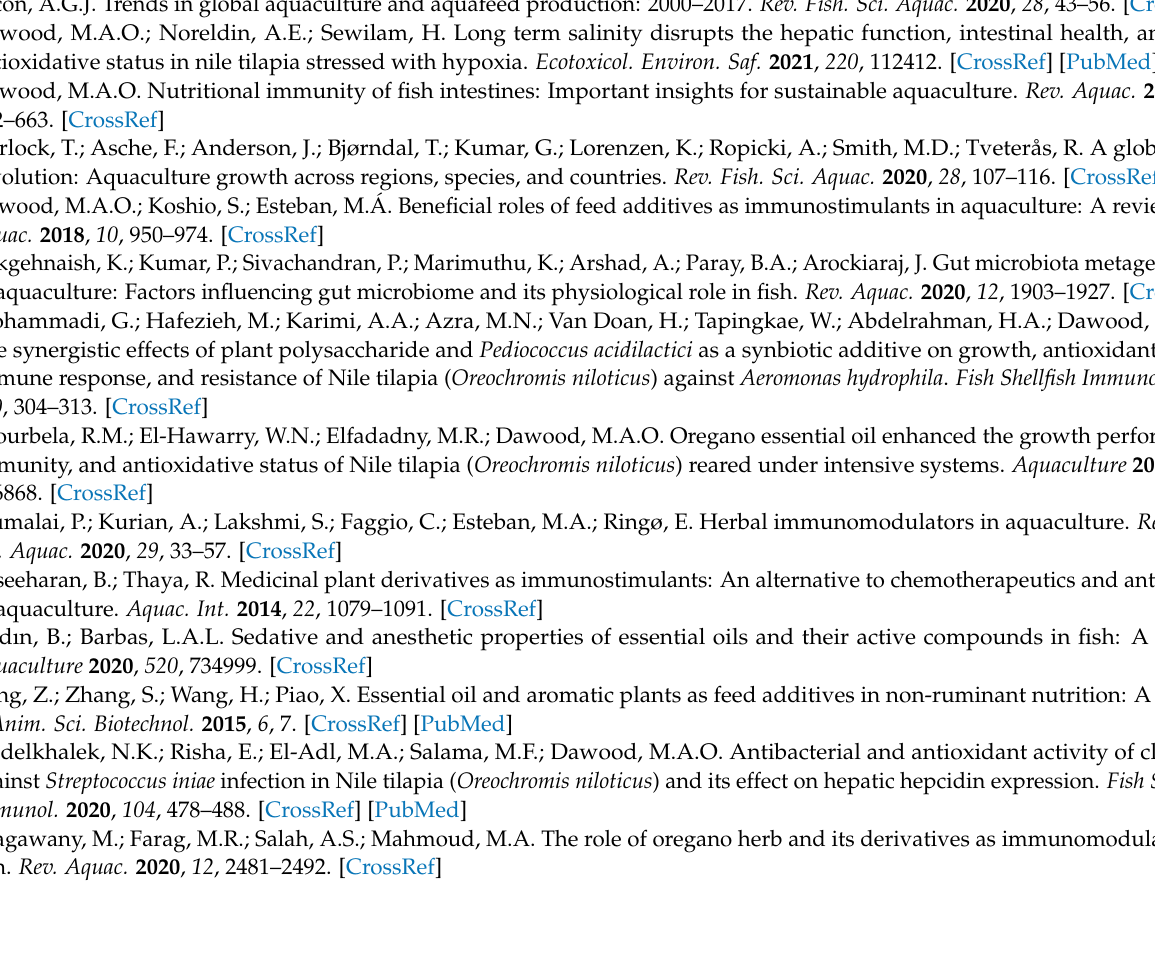
Table S4: β -caryophyllene in the essential oil constituents of its natural sources